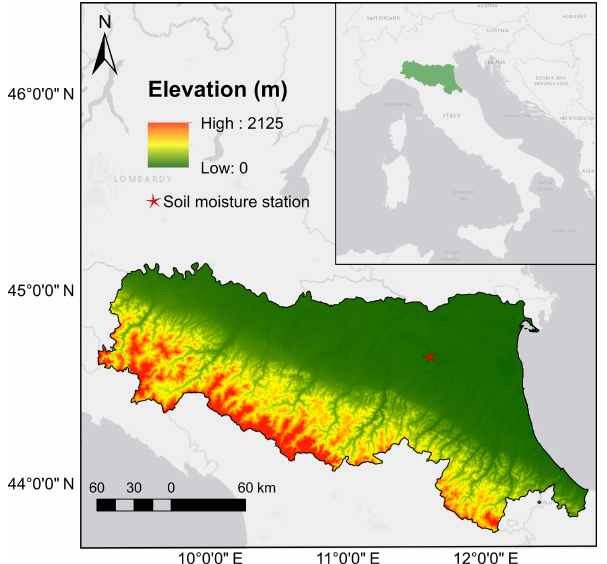
Figure 1. Location of the Emilia Romagna Region with elevation map and in situ soil moisture station also shown. The copyright of the background map belongs to Esri (Light Gray Canvas Basemap).